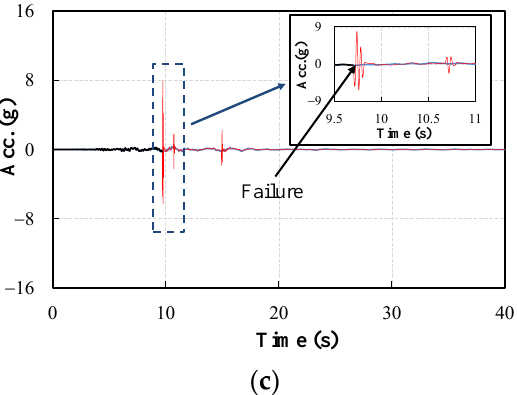
Figure 11. Accelerations of the 1st floor under the ground motions at a 1 ‱ PE in one year: ( a ) El Centro; ( b ) Kobe; ( c ) Northridge.